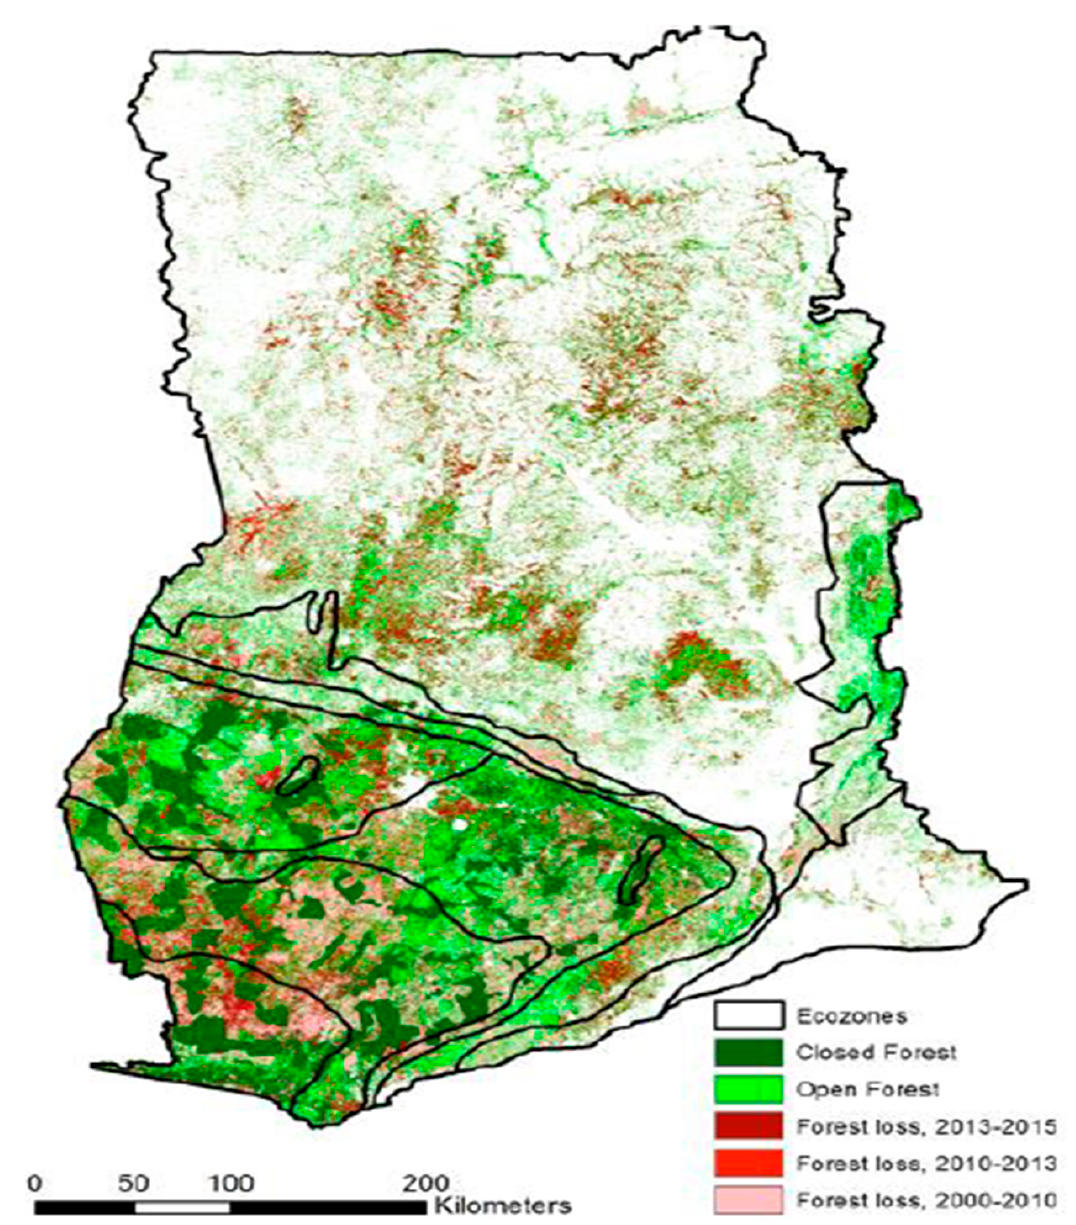
Figure 1 depicts Ghana’s forest cover map from the years 2000–2010, 2010–2013, and 2013–2015. The map shows deforestation related activities and their main crops responsible for the forest cover changes over the periods specified above. For details of these activities, see Table 2 under agriculture expansion.